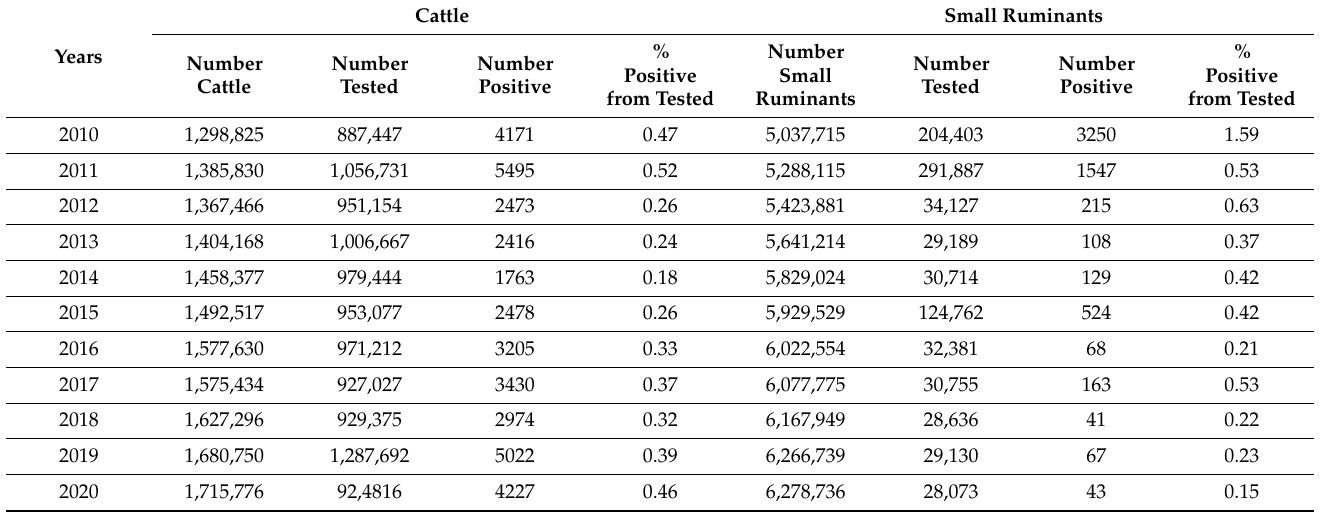
Table 5. Prevalence of brucellosis in Kyrgyzstan from 2010 to 2020 based on reports from the State Inspectorate for Veterinary and Phytosanitary Safety. Cattle and small ruminants were positive in two consecutive Rose–Bengal plate tests and/or serum agglutination tests, based on reports from SIVPS.